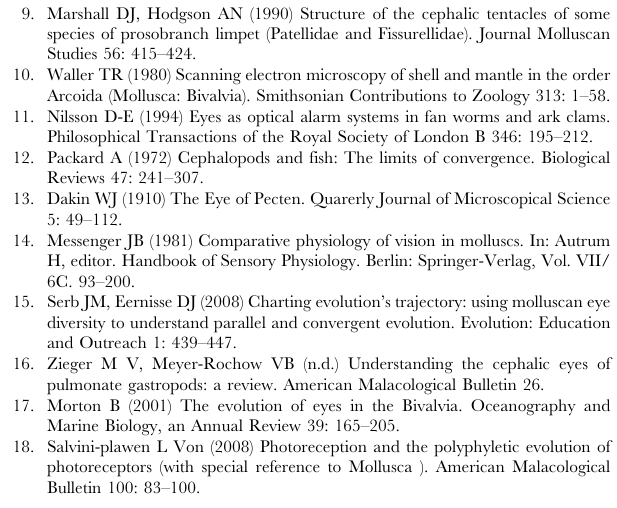
Figure S3 Amino acid alignments of scallop circadian clock genes to known homologs. Circadian clock gene sequences from the Placopecten magellanicus adult eye transcriptome were translated and aligned to known homologs from Drosophila , mouse, or Crassostrea gigas . Alignments were completed and exported from Geneious v. 5.6 (www.geneious.com). The graph above the alignment represents mean pairwise identity of each residue pair in each column, with green bars representing identical residues and missing bars highlighting areas where the sequences differ. End gaps in the alignments have solid green bars. Amino acids are shaded based on similarity, with black representing